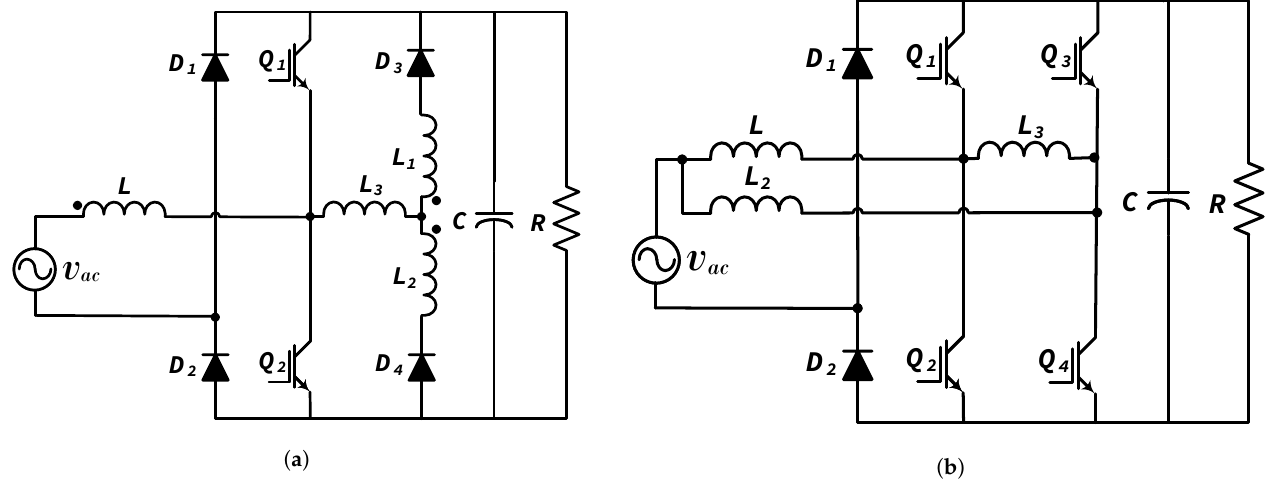
Figure 16. Interleaved boost converter: ( a ) totem pole topology; ( b ) GaN